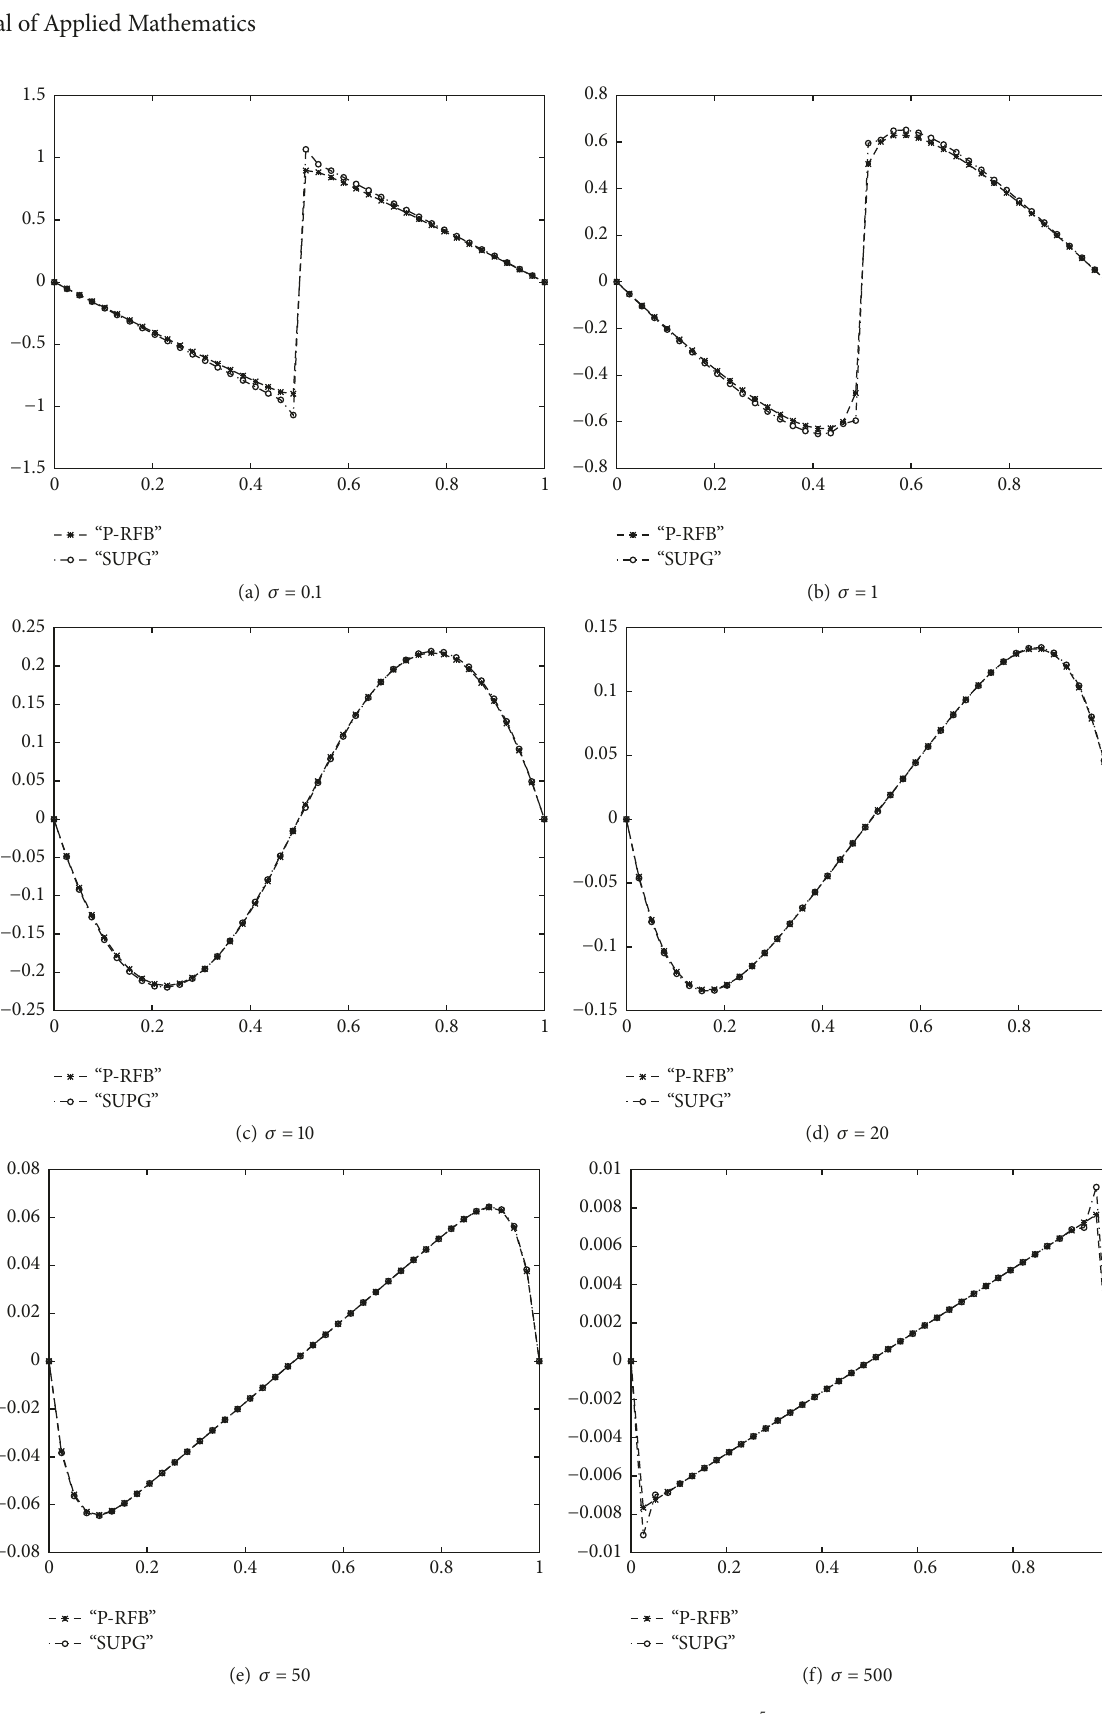
Figure 8: The numerical solutions when 𝑓(𝑥) = 4(2𝑥 − 1) , 𝜖 = 10 −5 , and 𝛽 = −2(2𝑥 − 1)